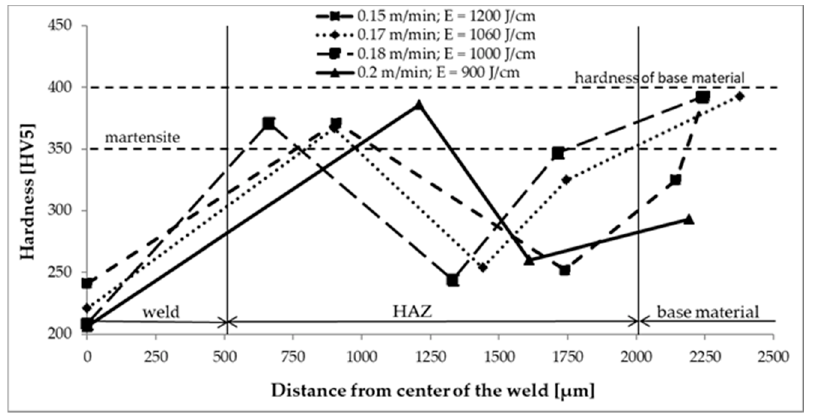
Figure 5. Schematic presentation of the weld carrying cross-section surface determination.